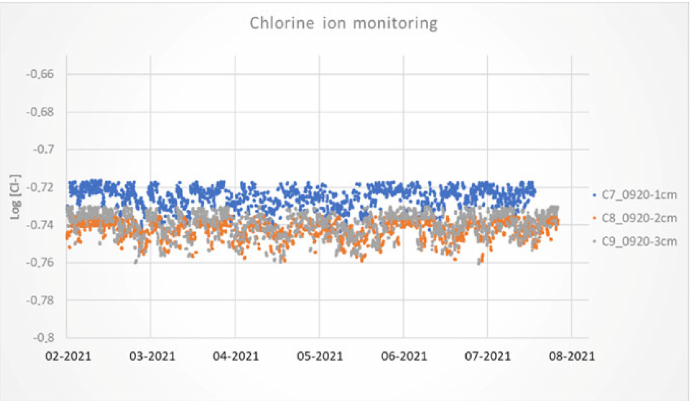
Figure 17. Variation trend of the pH concentration in the monitored concrete abutment.